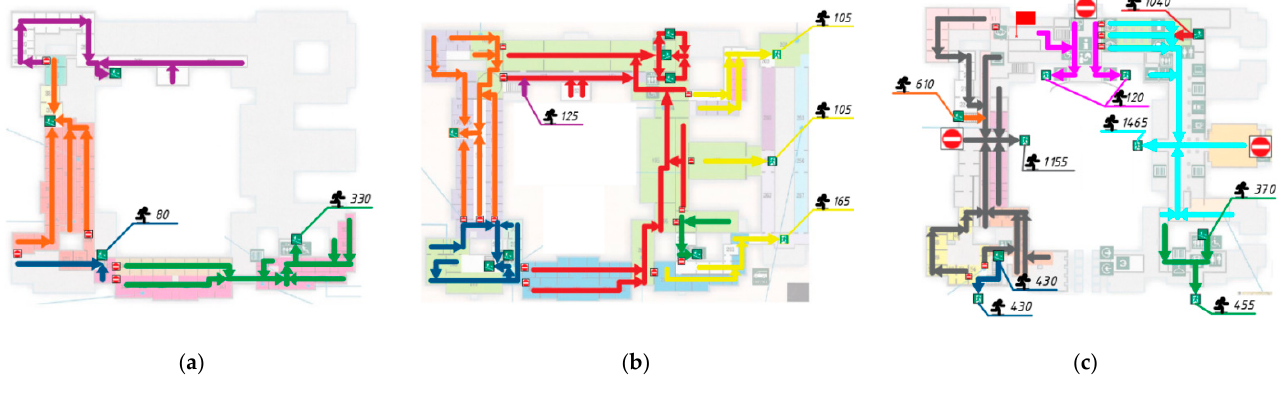
Figure 18. Scheme of evacuation of people from the Winter Palace for the scenario “Fire in the School Cloakroom”: ( a ) for the 3rd floor; ( b ) for the 2nd floor; and ( c ) for the 1st floor.